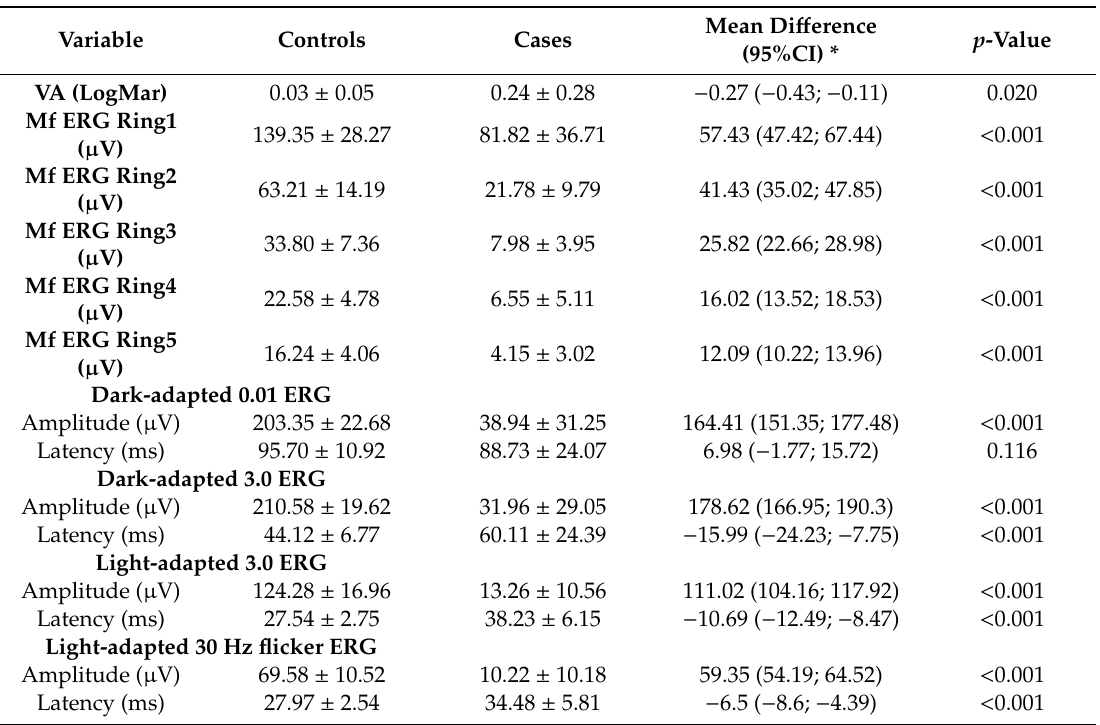
Table 2. Functional parameters of patients with RP and controls.